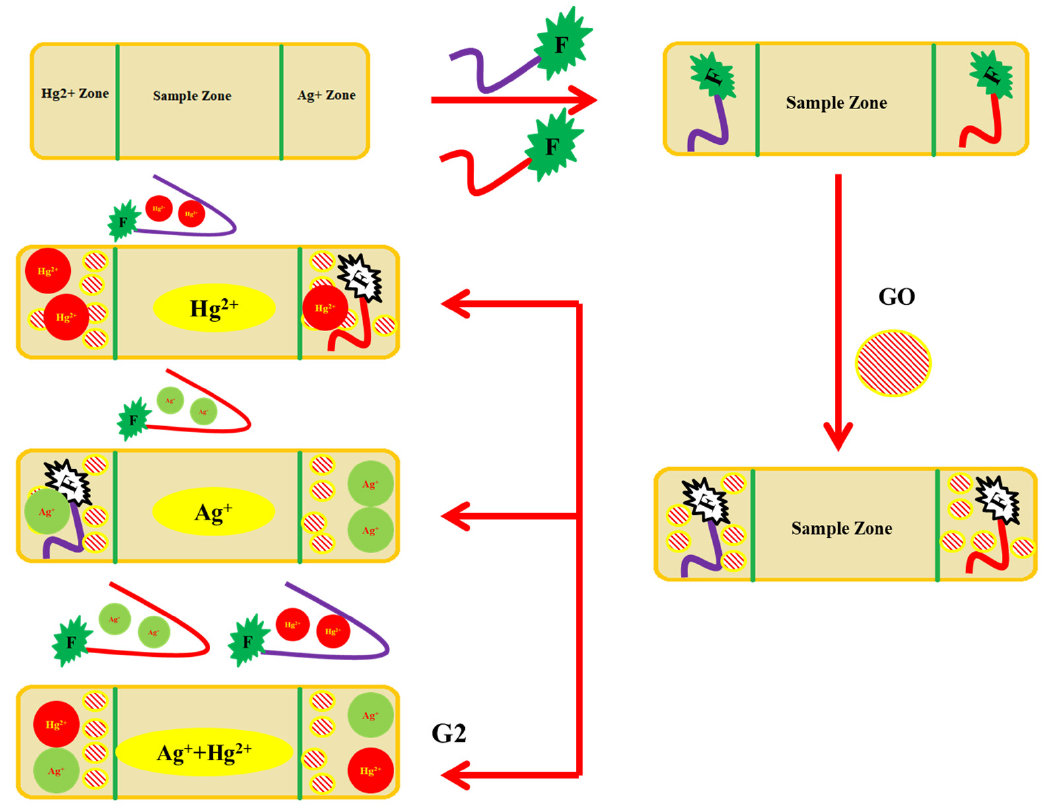
Figure 4. Schematic diagrams of the preparation of G2 and its dual Hg 2+ and Ag + sensing approaches. Reprinted from [55] with permission from Elsevier.